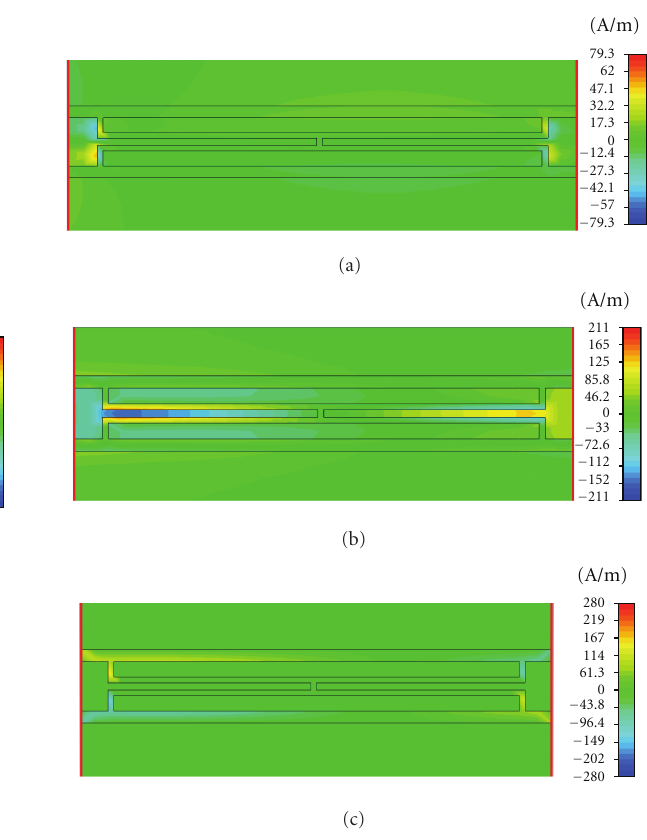
Figure 11: Magnetic field (A/m) distribution inside the discontinu- ity structure at 8GHz under quasi-TEM fundamental mode (a) H x , (b) H y , and (c) H z .